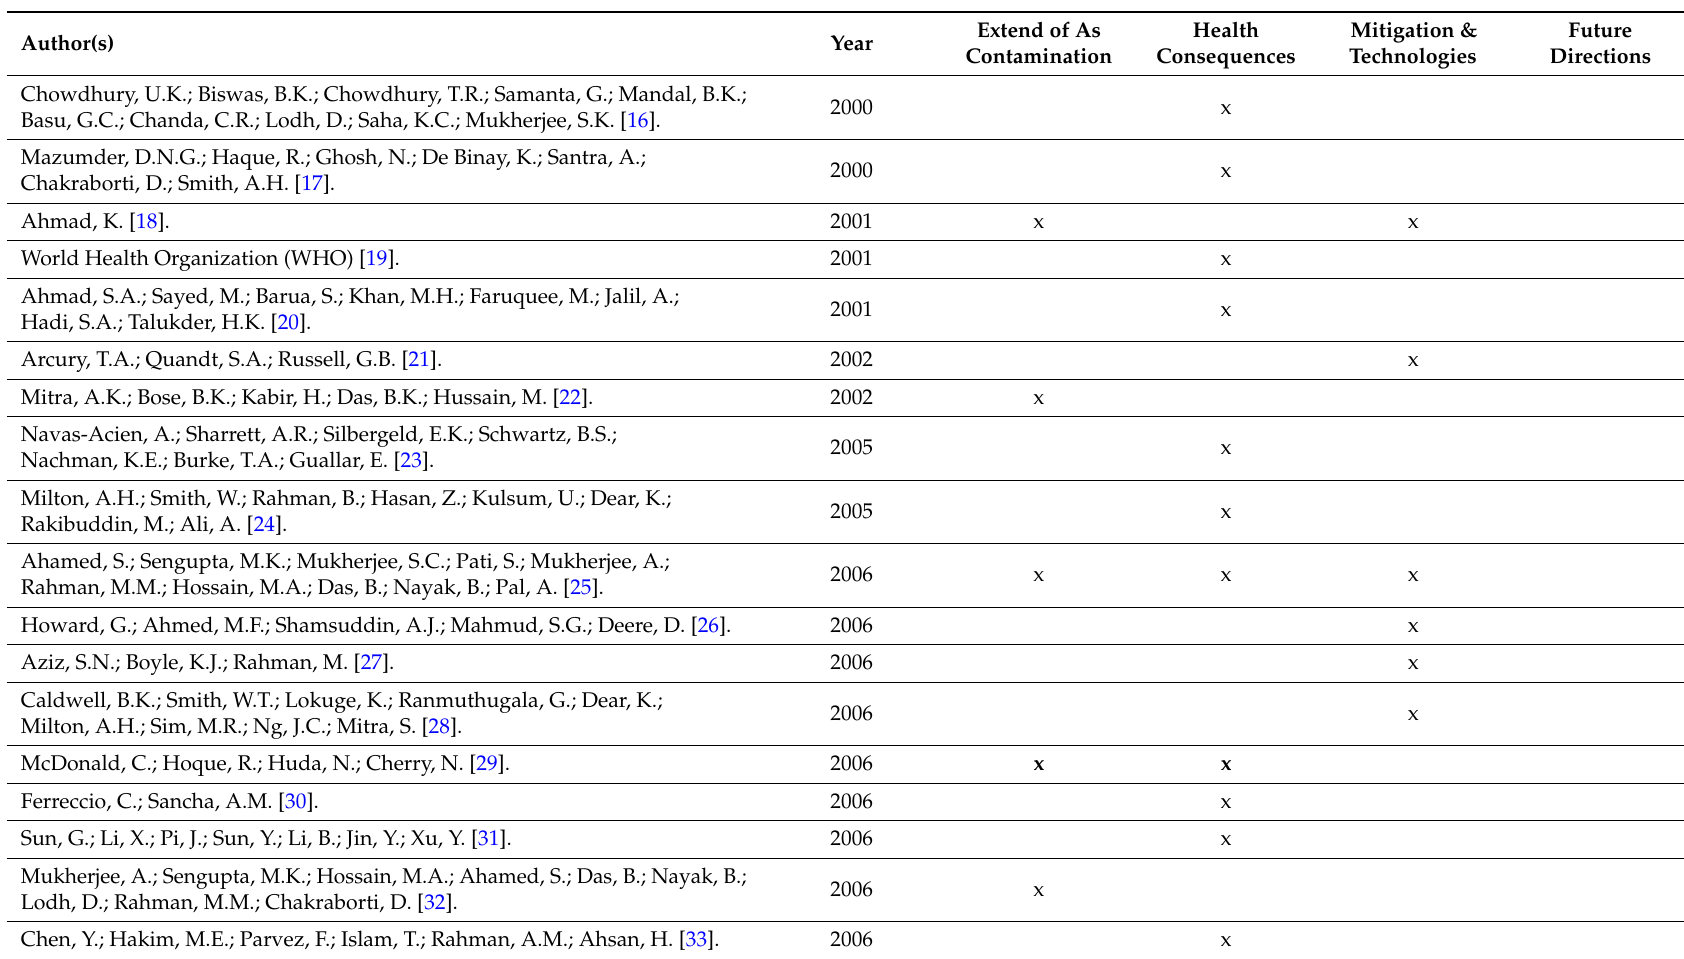
Table 1. Review matrix of arsenic research during the MDG